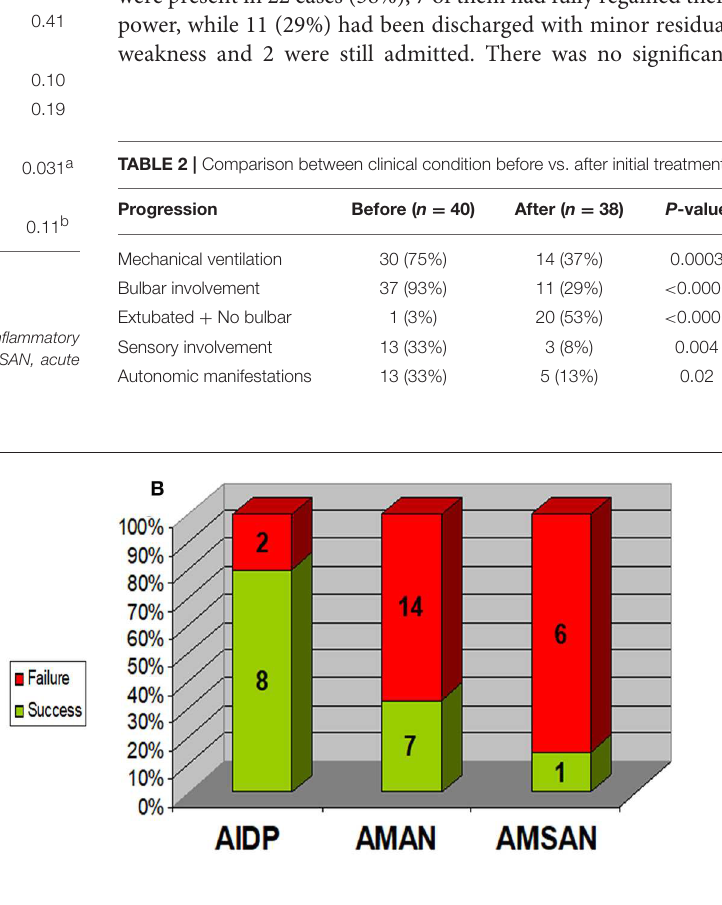
Frontiers in Pediatrics |